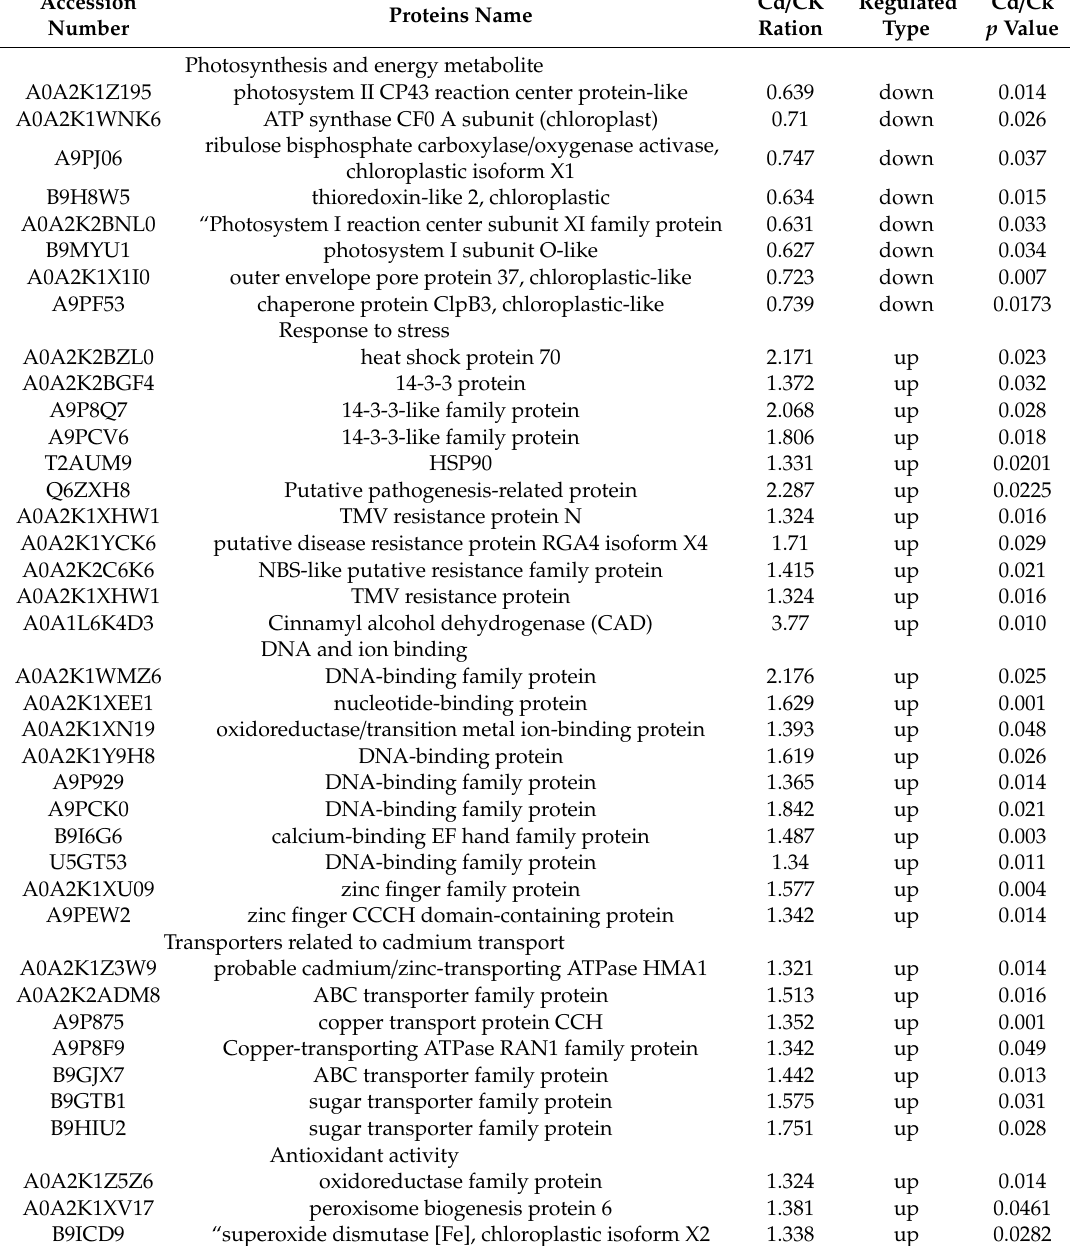
Table 5. List of partial proteins di ff erentially regulated by Cd and Cd + N in poplar plants determined by LC–MS / MS